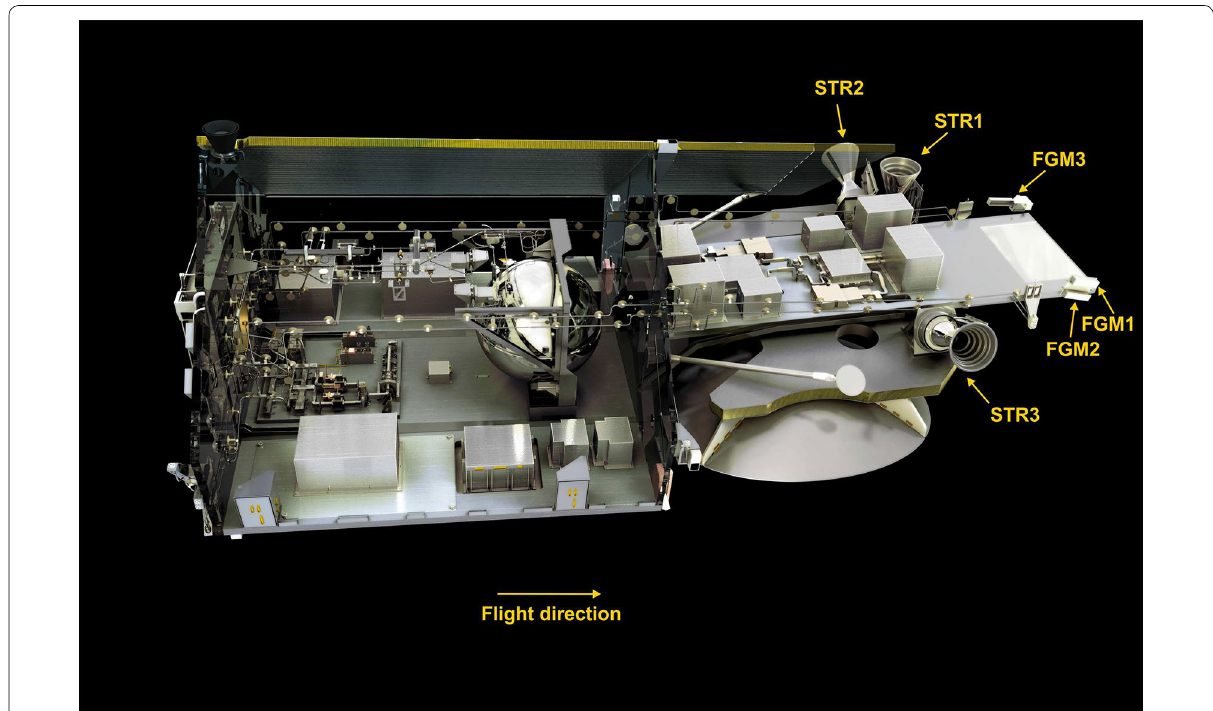
1 3 ) and star trackers (STR x , x = −